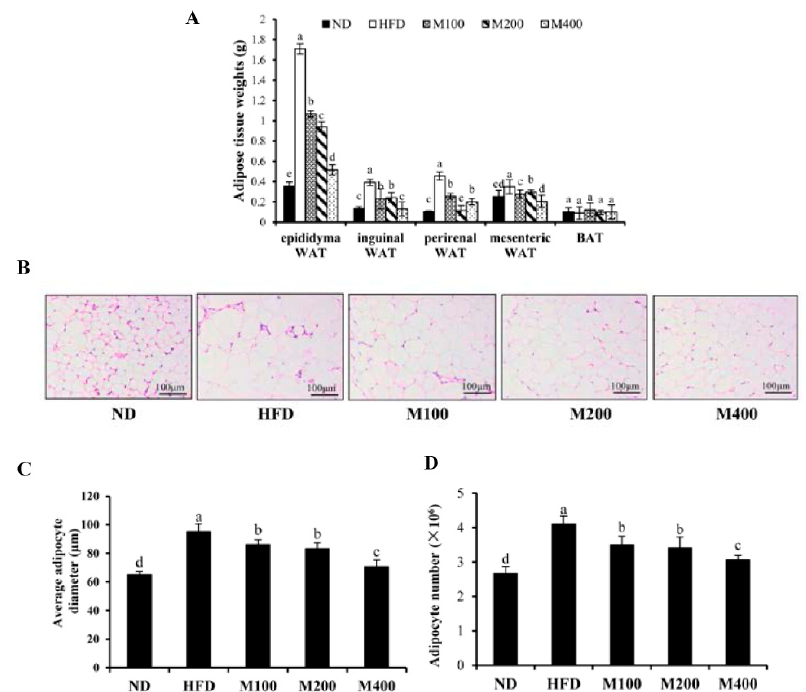
Figure 2. Effect of MFGM on adipose mass gain. ( A ) Changes in fat pad weights of epididymal white adipose tissue (WAT), inguinal WAT, perirenal WAT, mesenteric WAT and brown adipose tissue (BAT); ( B ) Representative hematoxylin and eosin staining of epididymal WAT; ( C ) Average adipocyte diameter of epididymal WAT. Scale bar: 100 µm, 200×; ( D ) The calculated adipocyte number in epididymal WAT. Means ± SE ( n = 6). Mean values with di ff erent letters indicate statistical significance ( p < 0.05).